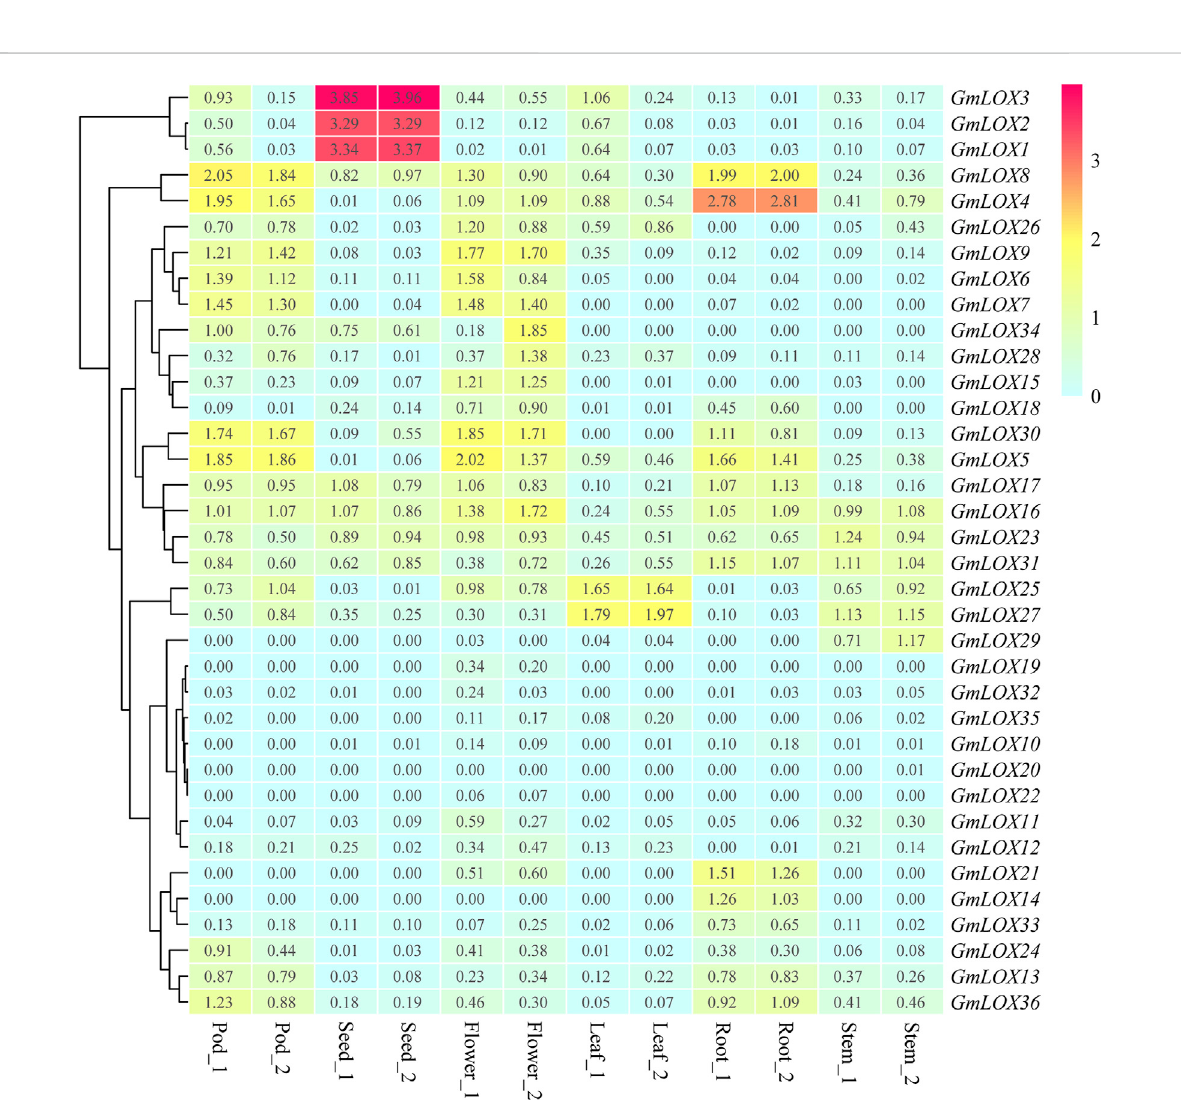
FIGURE 9 Heatmap of the expression patterns of GmLOX genes in different tissues based on transcriptome data Note: Root_1 and Root_2 are two biological duplications in roots ( R 2 > 0.85), and so on for other organizations. The log10 conversion value of expression values +1 (transcripts per million, TPM)was usedfor plotting. Light bluerepresents lowexpression,yellowrepresentsmedium expression,and redrepresents